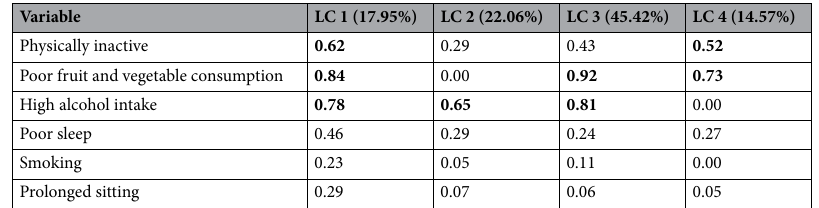
Table 2. Lifestyle risk behaviour probabilities of UK adults with CVD outcome data. Probability values ≥ 0.50 are in bold.